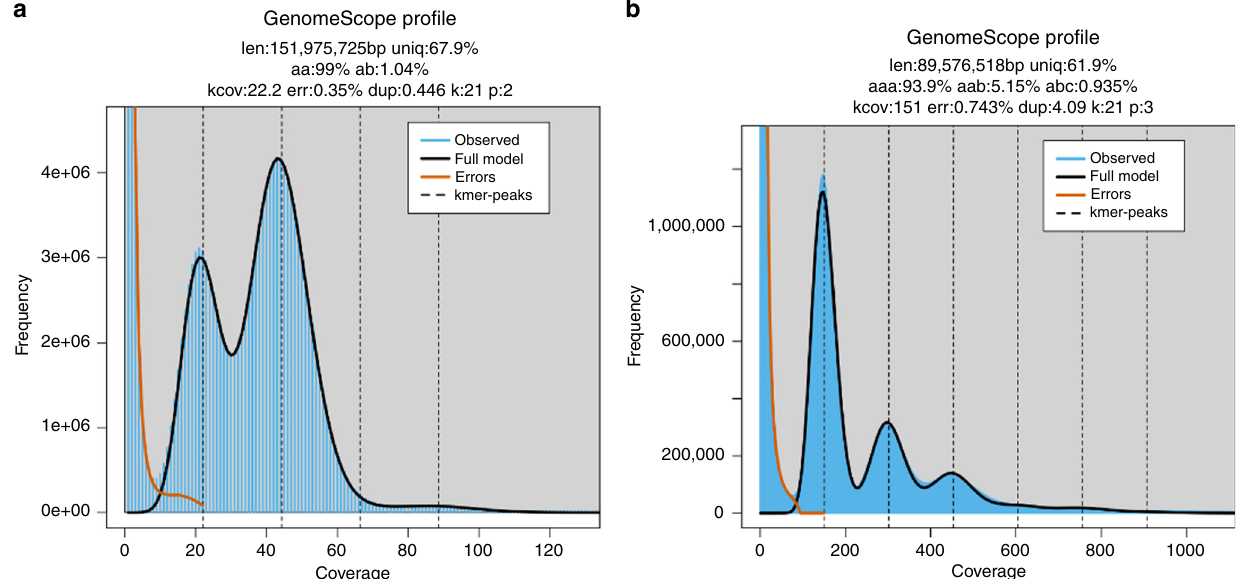
Fig. 1 GenomeScope plots for heterozygous species. K-mer spectra and fi tted models for ( a ) diploid Arabidopsis thaliana and ( b ) triploid Meloidogyne enterolobii . Note that the diploid plot has two major peaks, while the triploid plot has three major peaks. Both also have high frequency putative error k-mers with coverage near